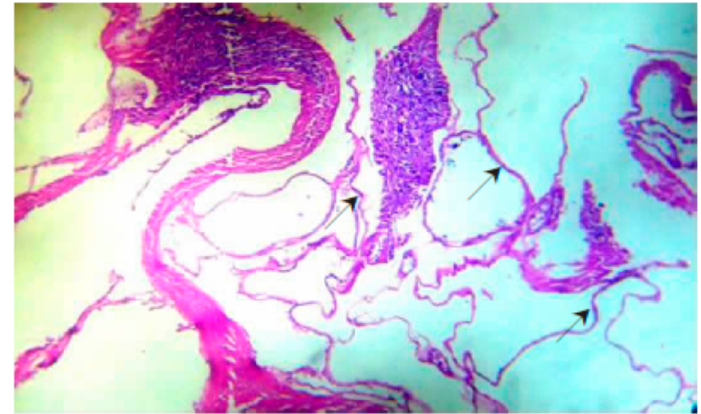
Figure 5. Liver pathology of the rodents infected with E. multilocularis ( × 400). Note: numerous metacestodes gather in groups, with germinal and laminated layers. laminated layers dropped from germinal layers. The laminated layers showing belt-shaped without cell structure curling in the cyst ( → ).